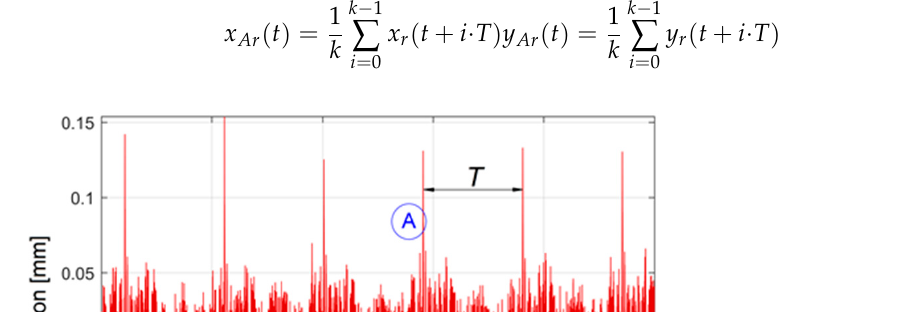
Figure 7. The evolution of residual y r from the harmonic fitting model for y -motion.